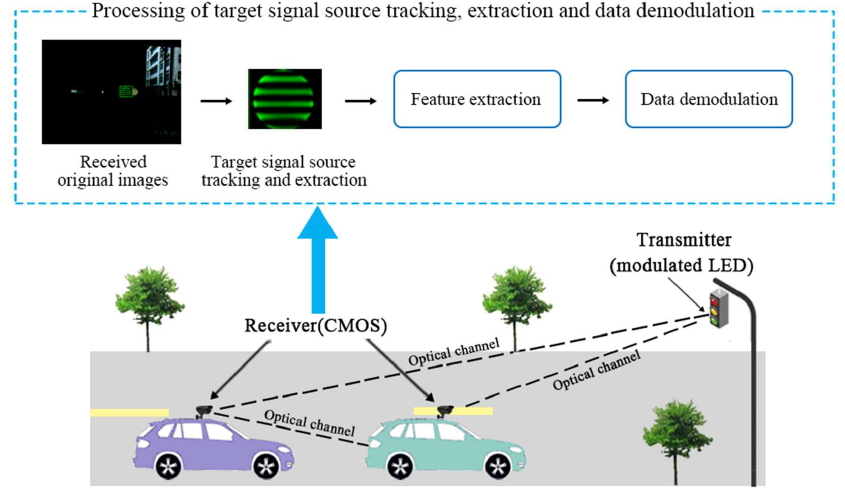
Figure 1. Geometric model of an OVLC system and processing in the receiver.